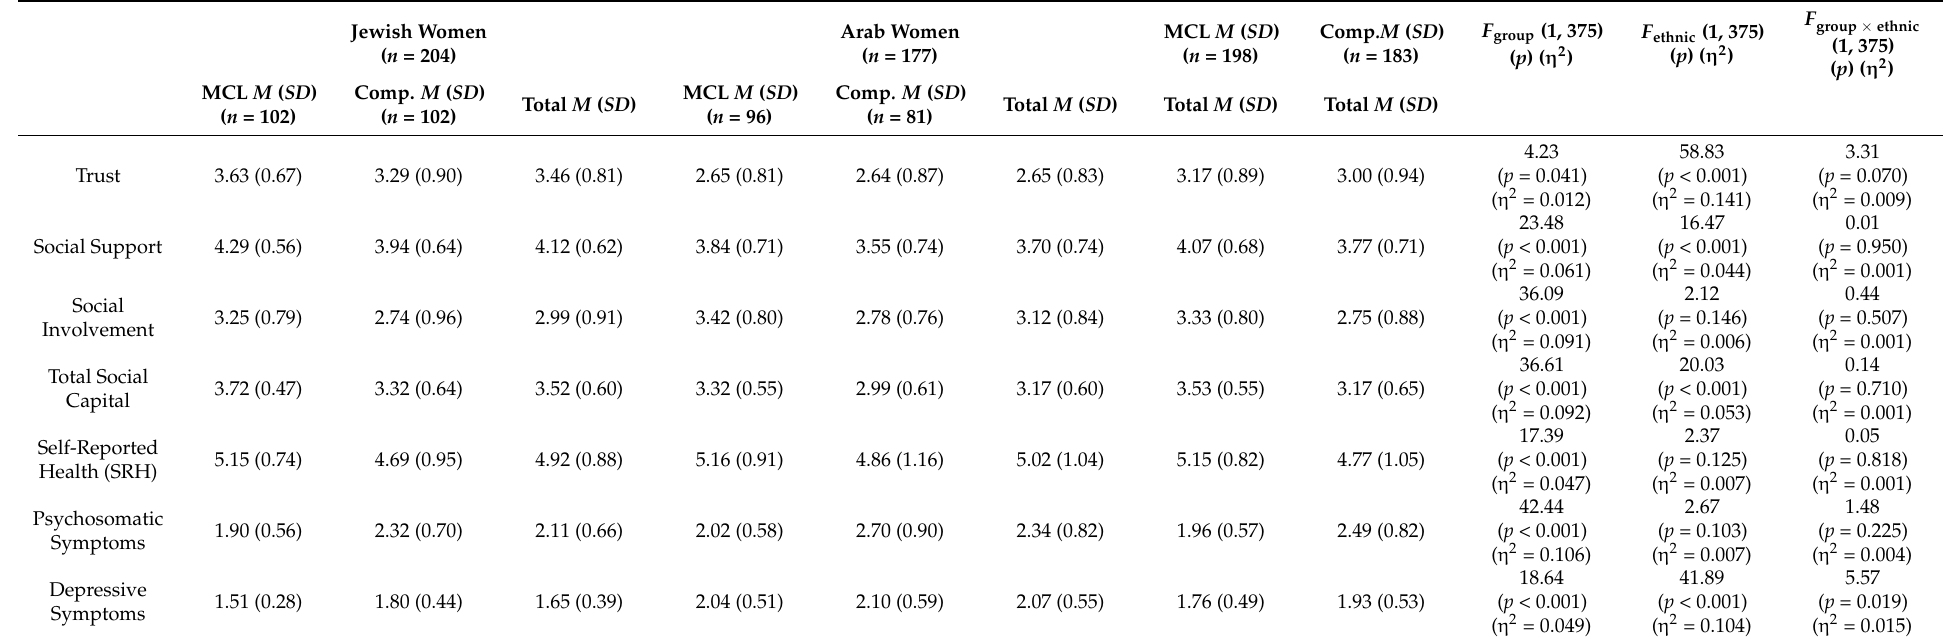
Table 3. Means, standard deviations, and F values for group and ethnic differences in the study variables (n =